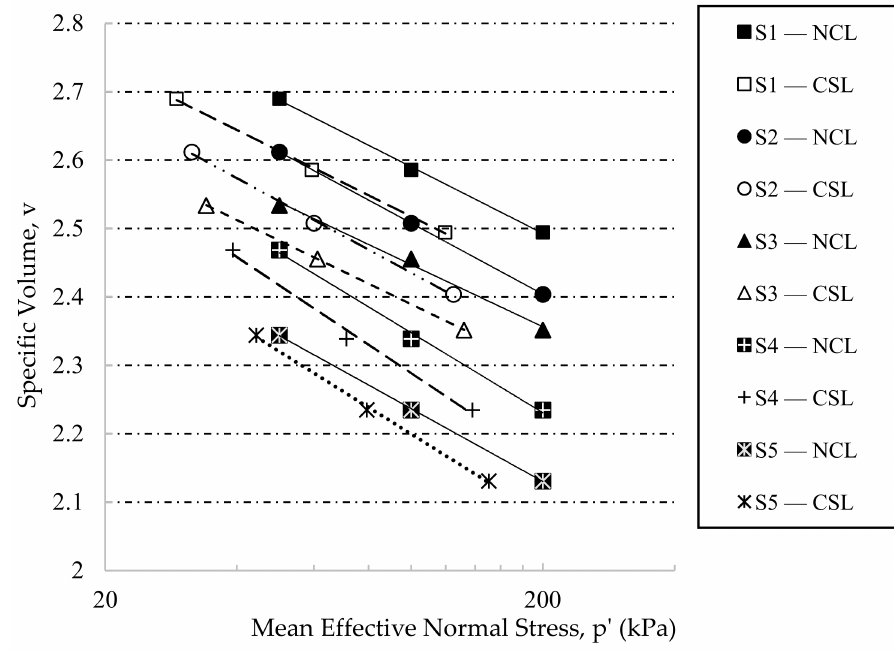
Figure 9. V-lnp relationship on a semi-logarithmic scale.